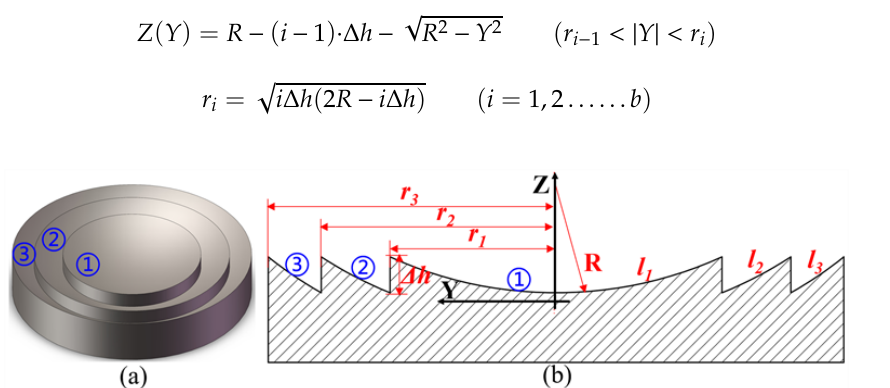
Figure 1. Fresnel micro-structured mold: ( a ) the 3D model; ( b ) the cross-section view.